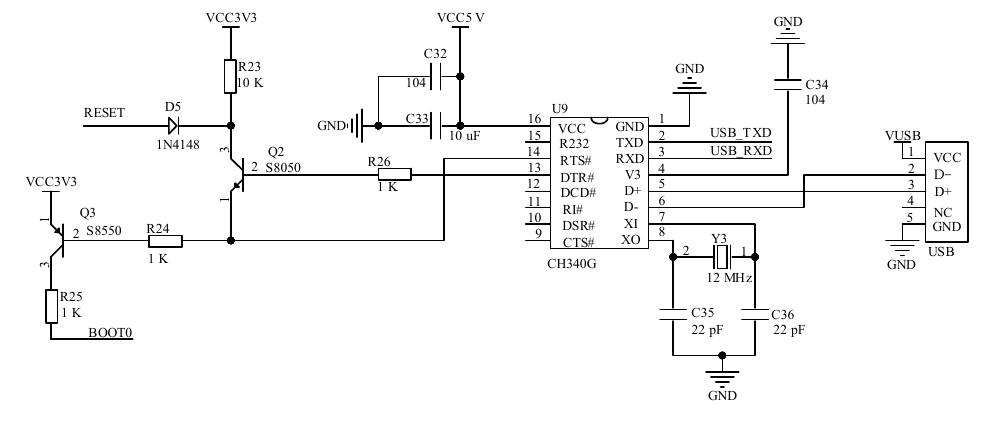
Figure 7. USB communication circuit.